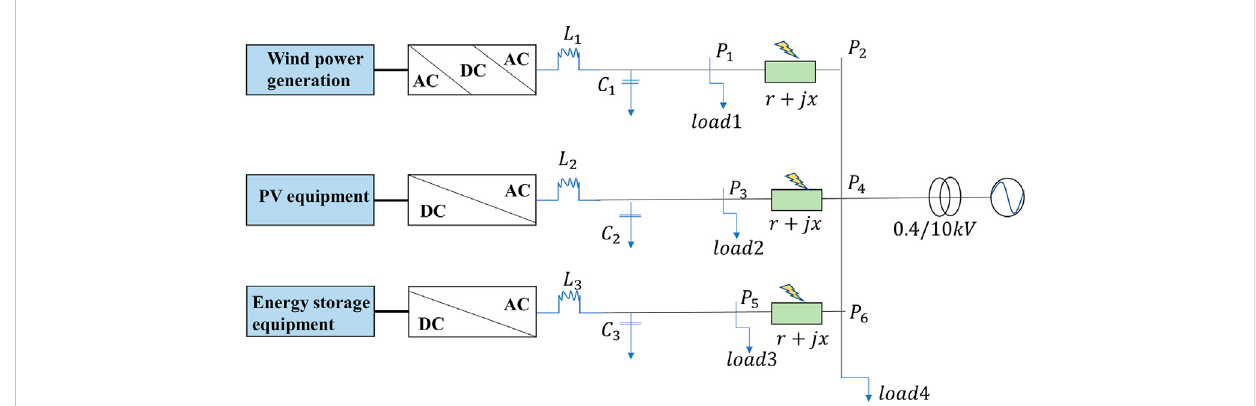
FIGURE 2 Structure of microgrid system. L 1 , L 2 , and L 3 are fi lter inductances; C 1 , C 2 , and C 3 are fi lter capacitors; Load1, Load2, Load3, and Load4 are electrical loads; r is line resistance; x is line